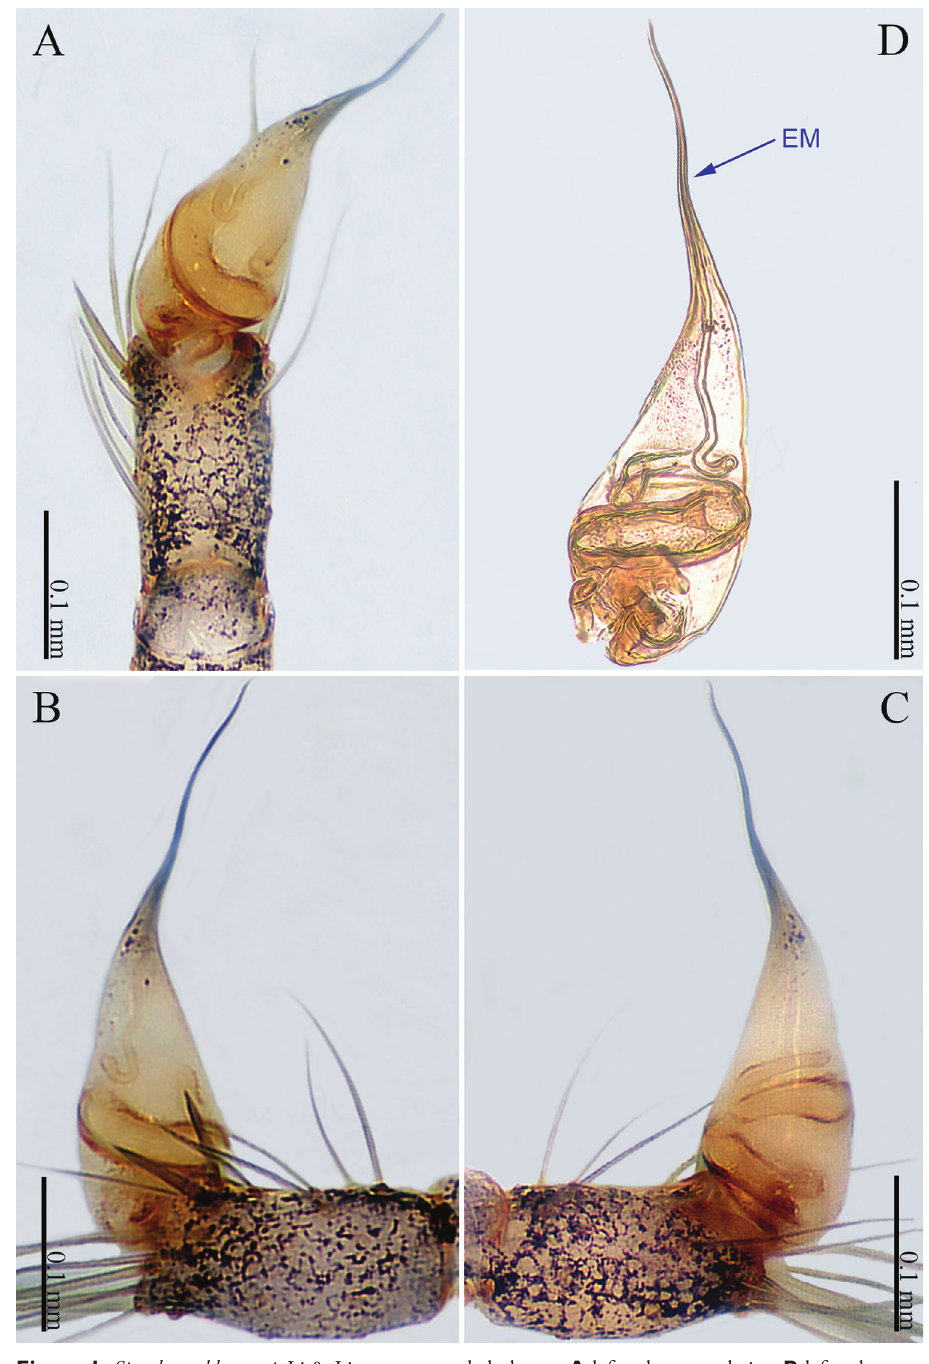
Figure 1. Sinoderces khanensis Li & Li, sp. nov., male holotype A left palp, ventral view B left palp, pro- lateral view C left palp, retrolateral view D right palpal bulb, prolateral view. Abbreviation: EM